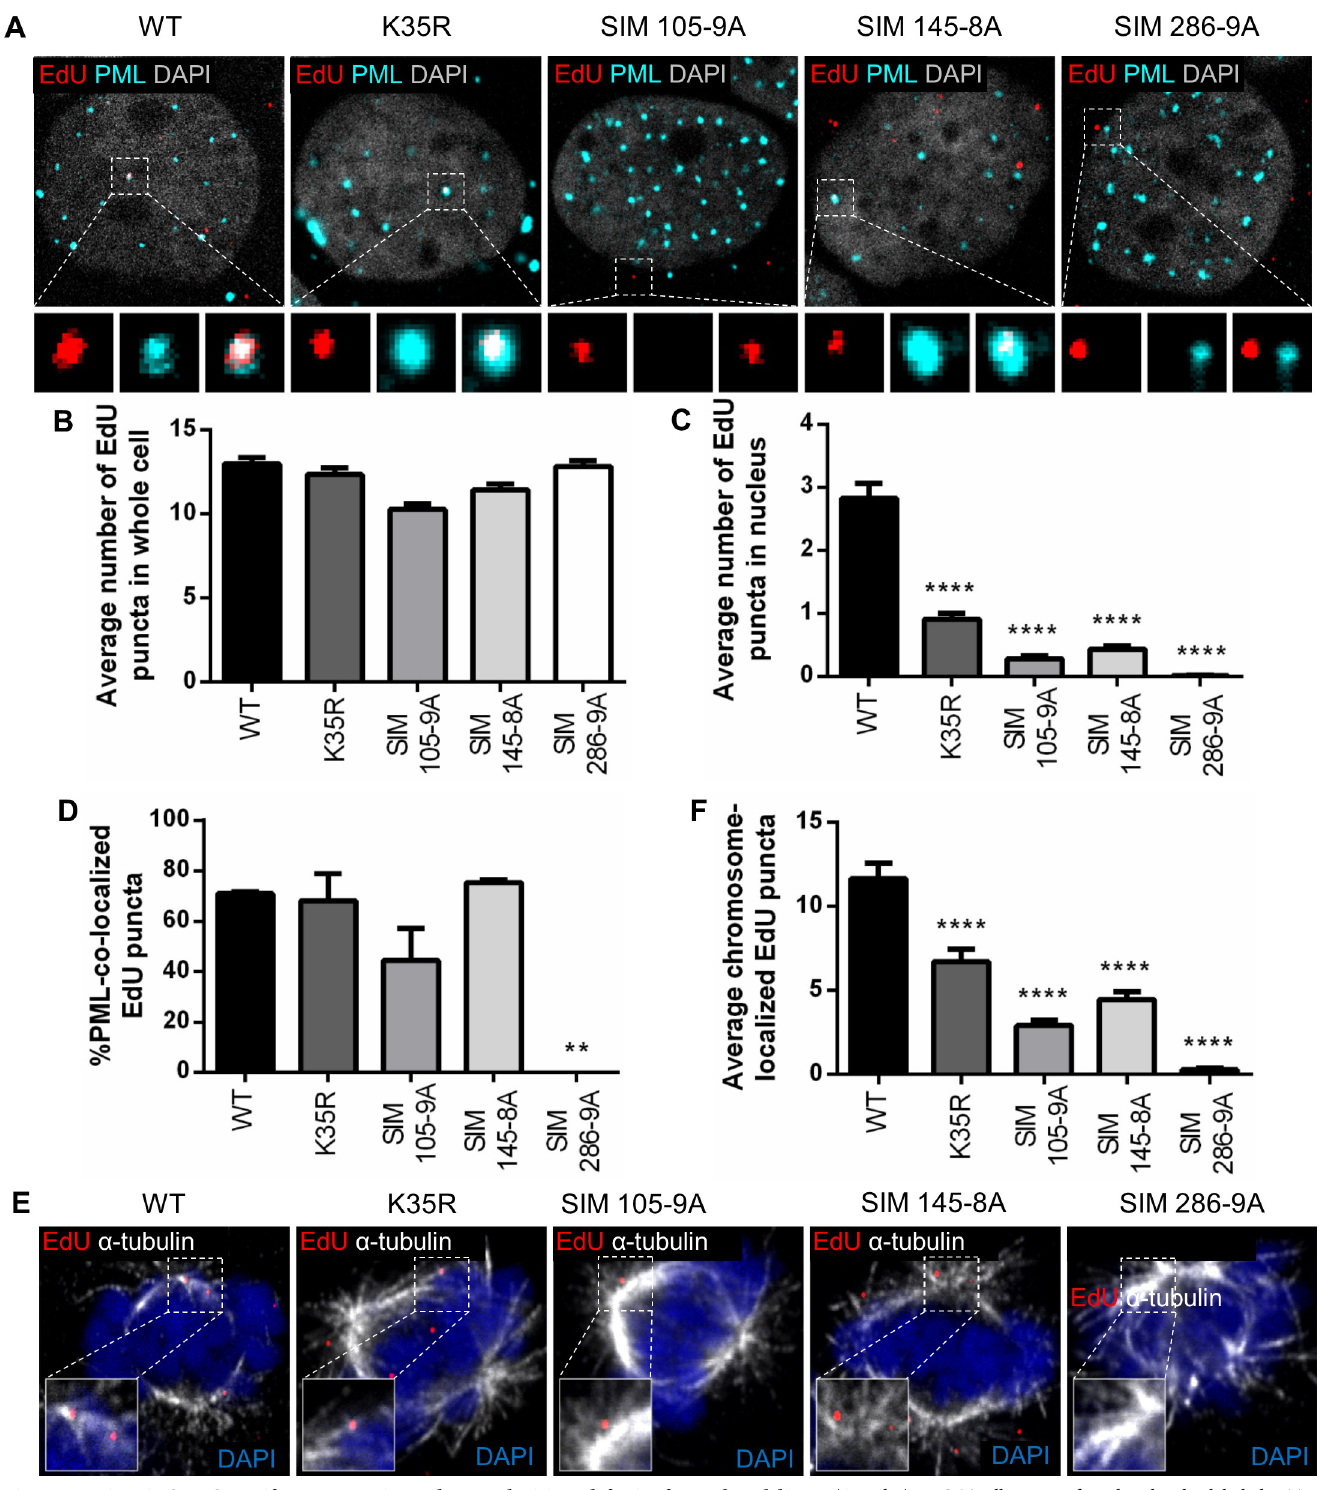
Fig 9. Mutations in SUMO motifs on L2 protein render pseudovirions defective for nuclear delivery. (A and E) HaCaT cells were infected with EdU-labeled WT or mutant PsVs for 24 h, fixed, permeabilized, and treated with AF555 (red) in Click-iT reaction buffer. Next, cells were incubated with rabbit anti-PML protein antibody (cyan) (A) or mouse anti- α -tubulin antibody (white) (E) and mounted with DAPI (white (A), blue (E)). (A) Representative confocal images of EdU and PML localization in interphase cells. (E) Representative confocal images of EdU on microtubules in mitotic cells. (B) Number of EdU in whole cell was determined by